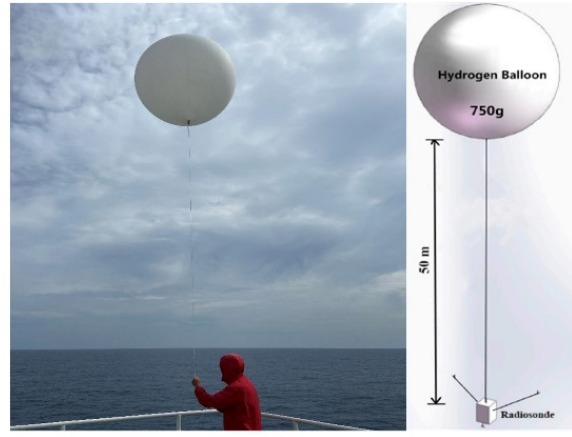
Figure 2. Launching a balloon-borne radiosonde.